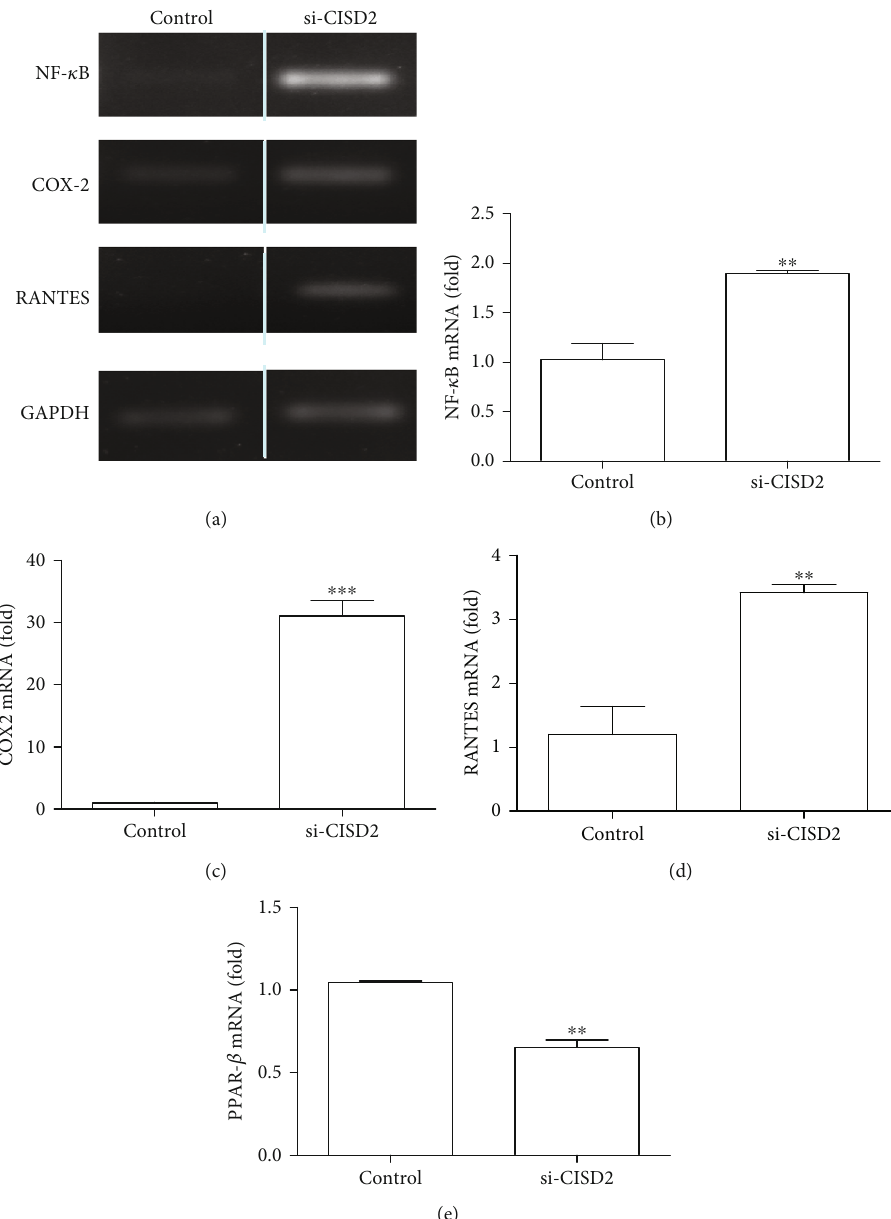
Figure 3: Knockdown of CISD2 expression in neural cells signi fi cantly in fl uenced mRNA expression levels in PPAR- β , indicating upstream regulation of CISD2 on PPAR- β (a). mRNA levels of NF- κ B, COX-2, and RANTES were determined by semiquantitative RT-PCR in neural cells with or without si-CISD2 transfection. The results shown are from one of the experiments that were repeated for at least 3 times. Quanti fi cation of relative band intensity of semiquantitative RT-PCR showed that CISD2 knockdown in neural cells led to enhanced mRNA expression levels in NF- κ B (b) and downstream proin fl ammatory mediators including COX-2 (c) and RANTES (d). (e) Results of real-time qRT-PCR for mRNA levels of PPAR- β in neural cells with or without si-CISD2 transfection. Vertical bars indicate the mean ± standard errorof themean (SEM) of mRNA expression ( n = 3 ). ∗∗ P < 0 : 01 and ∗∗∗ P < 0 : 001 indicate a statistically signi fi cant di ff erence between the control and si-CISD2 groups using independent two-sample t